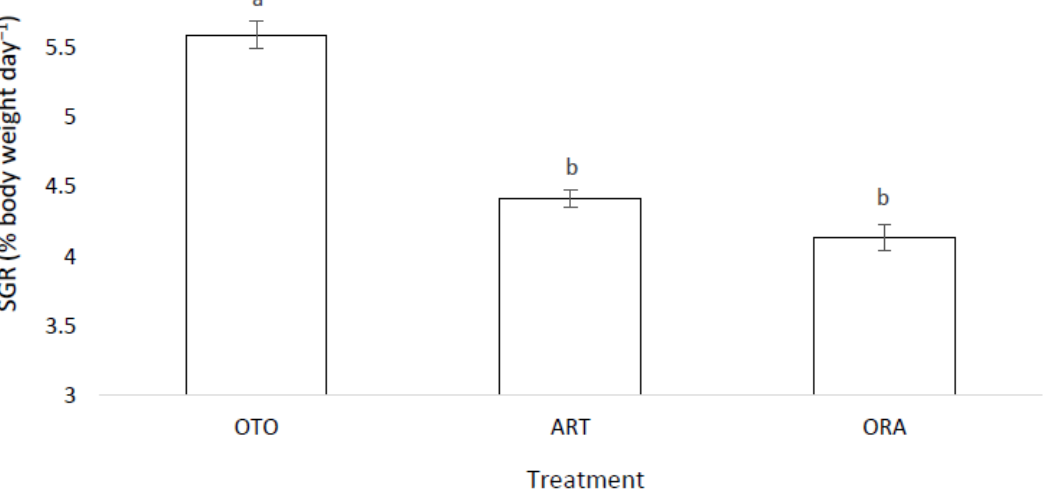
Figure 4. Mean specific growth rate (SGR) for larval giant kōkopu for three different feed treatments; OTO (Otohime), ART (Artemac) and ORA (O.range) (mean ± SE). Means with different superscripts are significantly different ( p < 0.05).